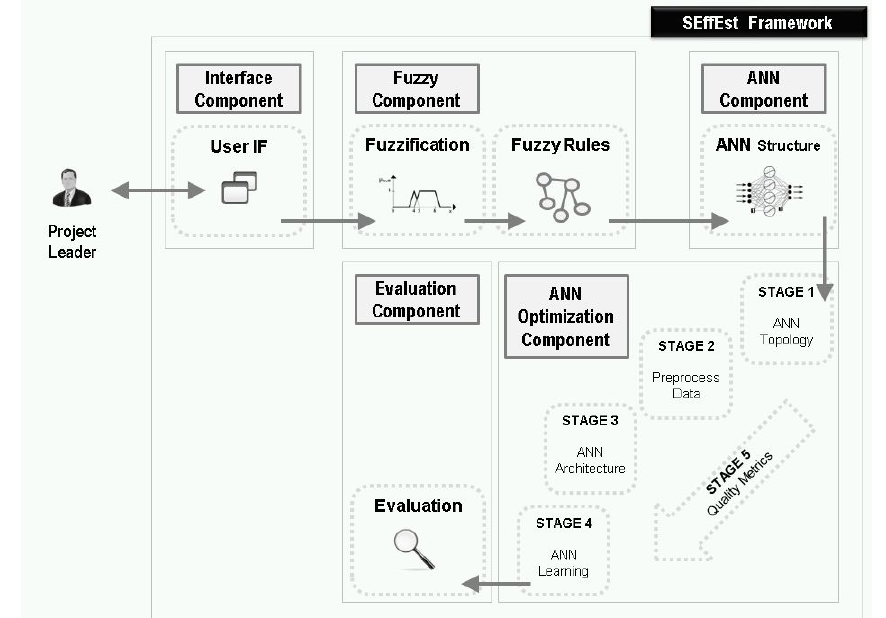
Figure 1: SEffEst